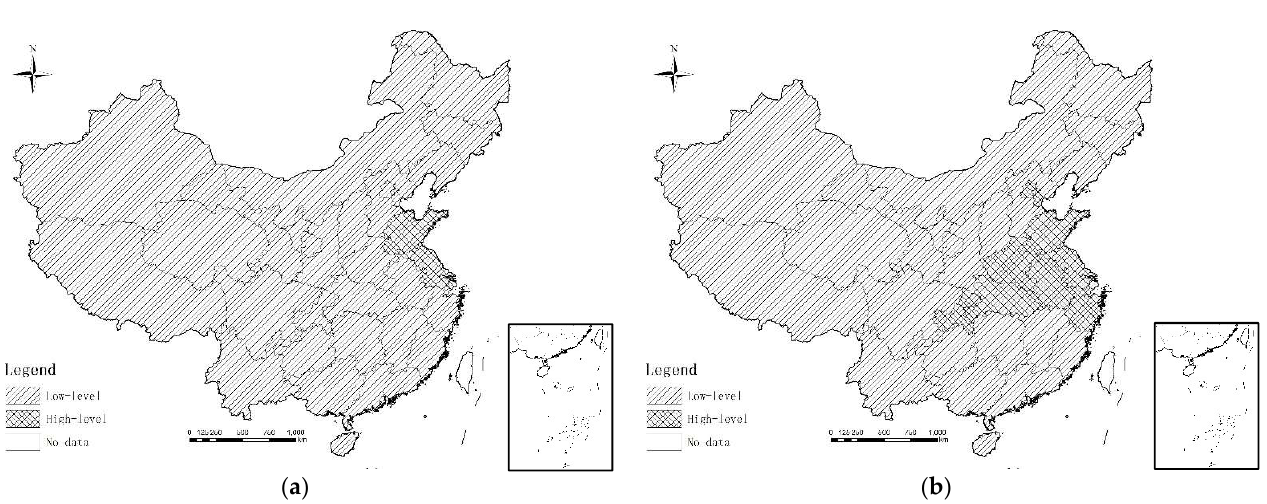
Figure 6. Distribution of interval division by highway density. ( a ) Average of highway density, ( b ) highway density in 2017.